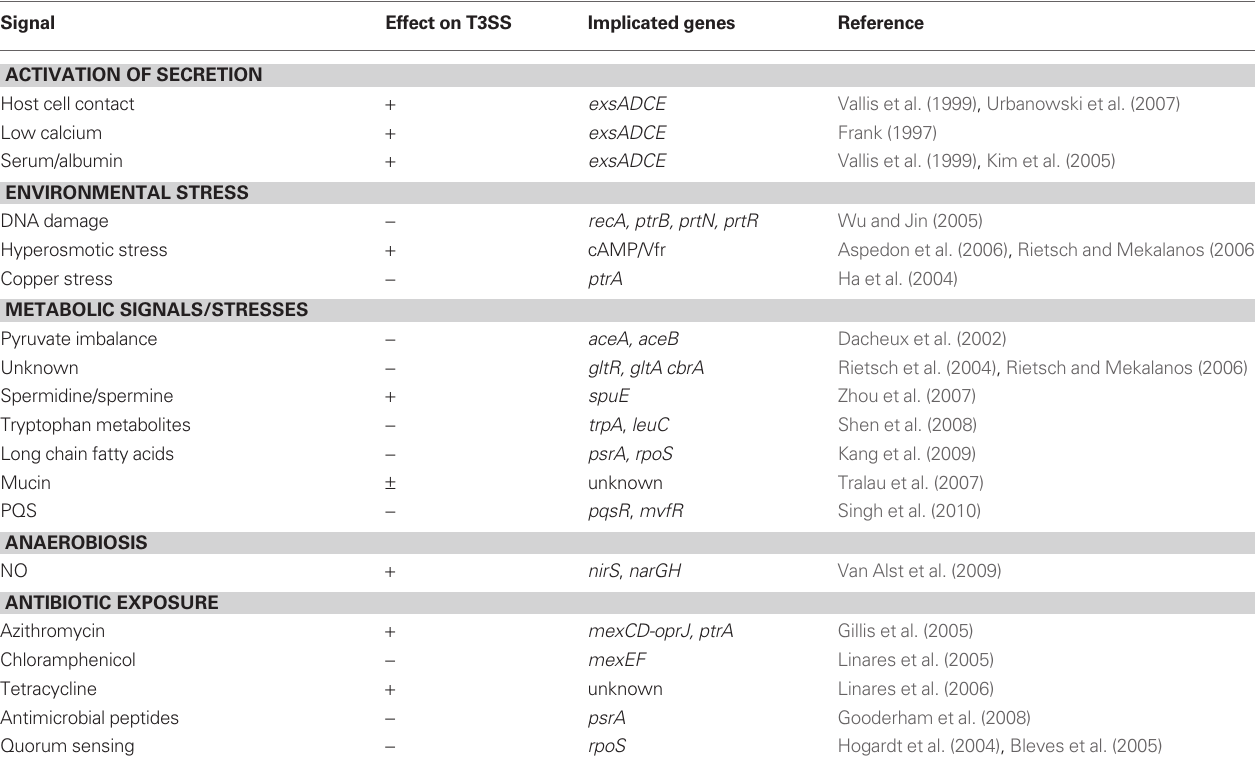
Table 1 | Environmental signals that influence T3SS gene